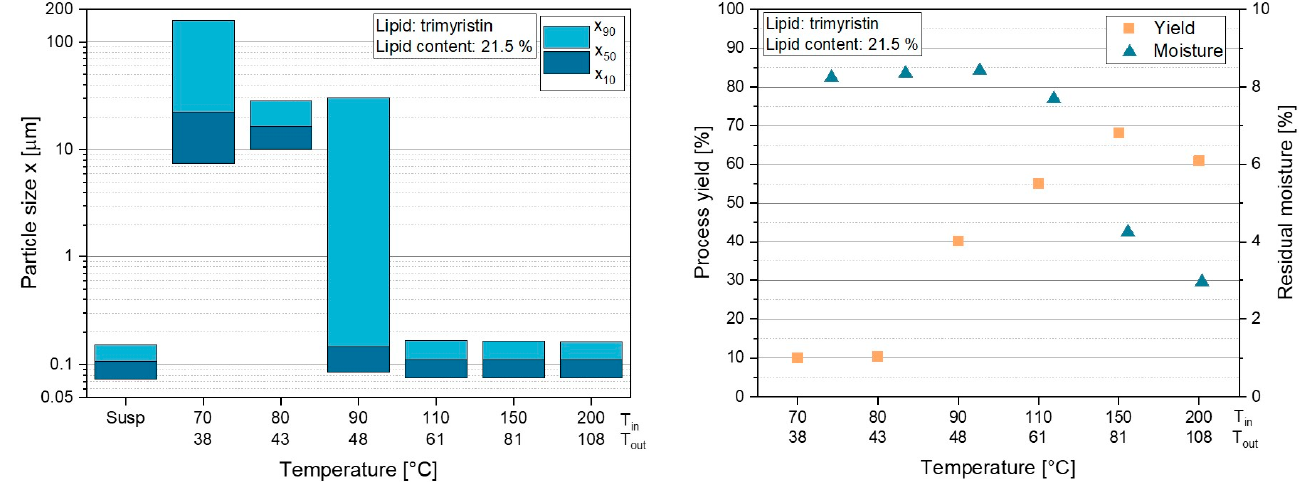
Figure 7. Influence of drying temperature T in and the resulting T out on the particle sizes after powder redispersion ( left ) and the process yield as well as residual moisture of the powders ( right ). The experiments were performed with a trimyristin suspension with 21.5 wt.% embedded lipid in the lactose/SDS matrix during drying.